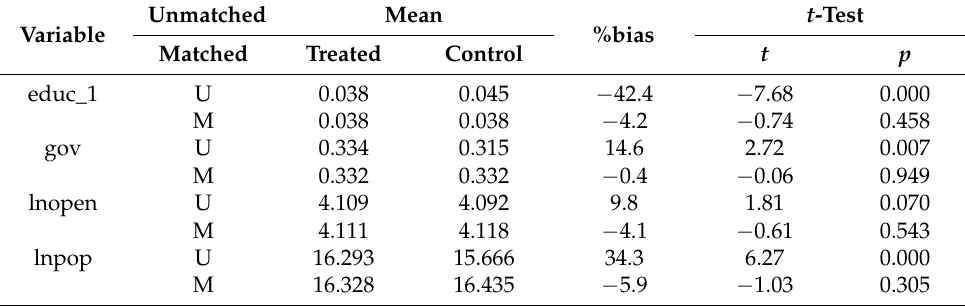
Table 3. Balance test results of